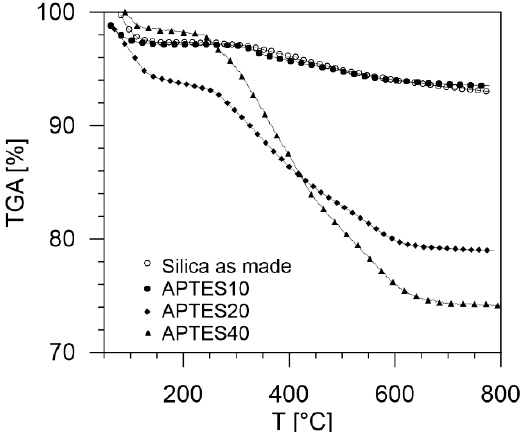
Figure 4. TG analysis of the as-made and APTES-grafted silicas before the adsorption tests data of as-made silica, APTES20, and APTES40 from reference [35].